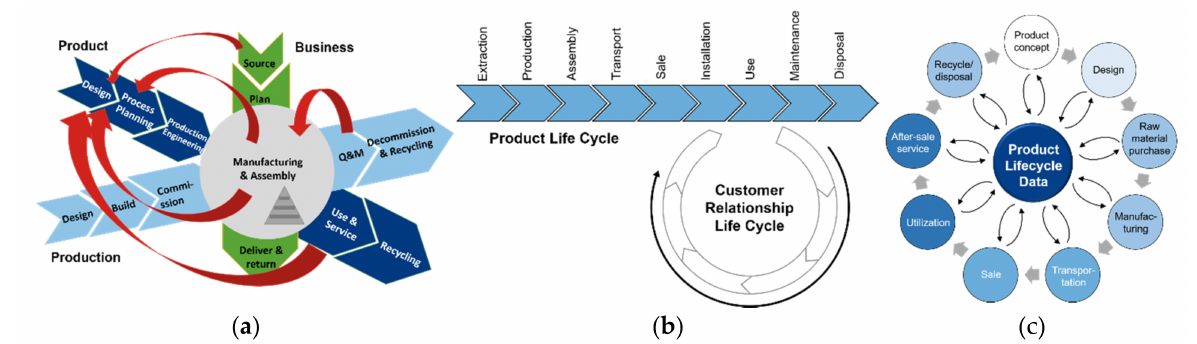
Figure 3. Integrative perspectives of the product lifecycle: ( a ) product, production and business perspectives represented by chain-like lifecycle visualizations (detailed in [48]); ( b ) product and service lifecycles integrated into product–service systems (adopted from [54]; ( c ) integrative view with macro-cycle and internal micro-cycles in each phase enabling Smart Manufacturing (based on